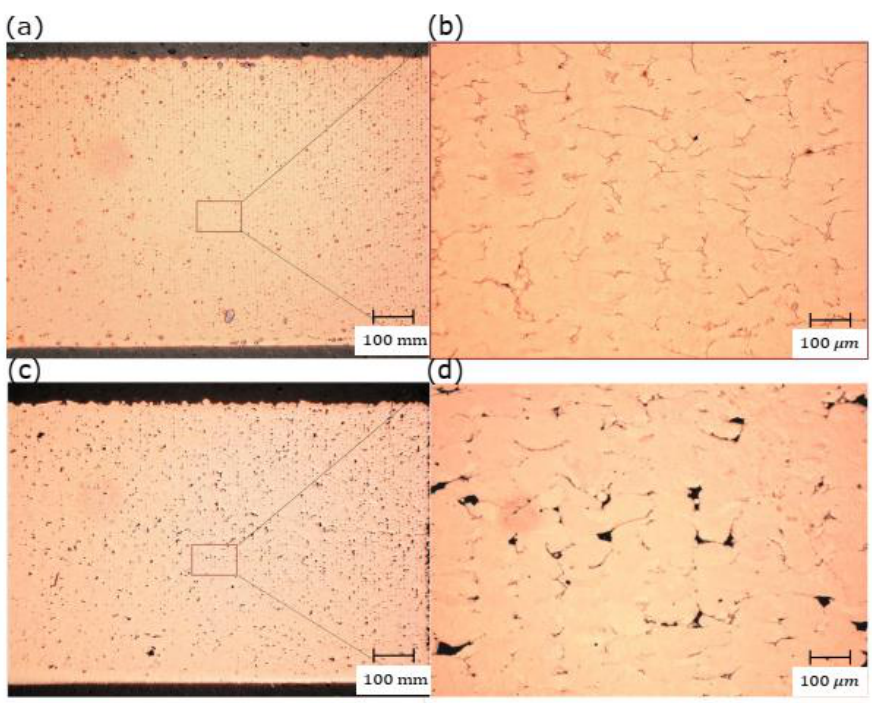
Figure 12. Optical micrographs of the cross-section of L-PBF Cu samples manufactured under 370 W laser power, 600 mm/s scanning speed, and 0.1 mm hatch spacing with two different preheating temperatures: ( a ) 200 °C and ( c )120 °C; ( b ) and ( d ) are the corresponding high magnifications, respectively.